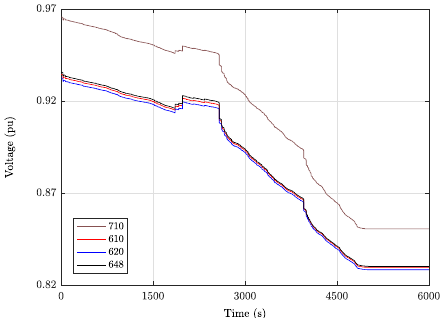
Figure 10. Voltage response at Acharnon (610), Koumoundourou (620), Ag. Stefanos (648) and Rouf (710) substations, stable scenario.